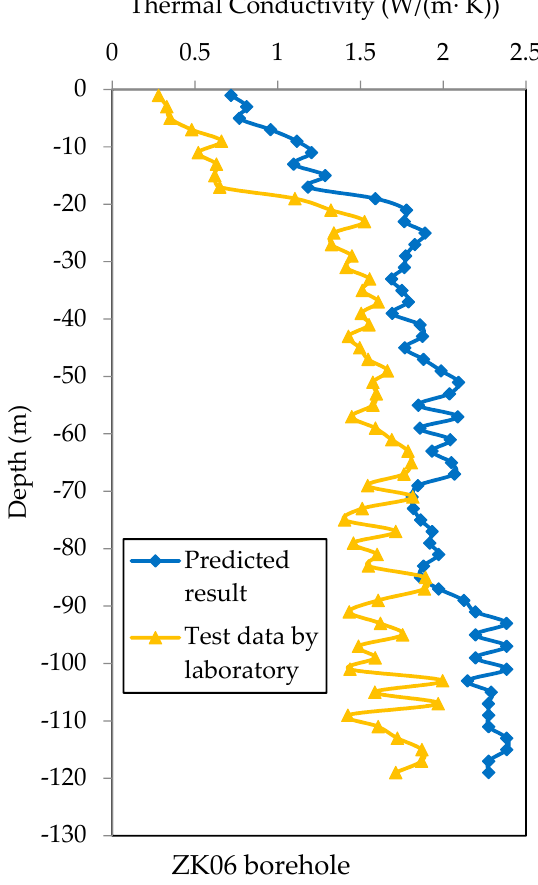
Figure 18. Prediction results of layered thermal conductivity for ZK06.